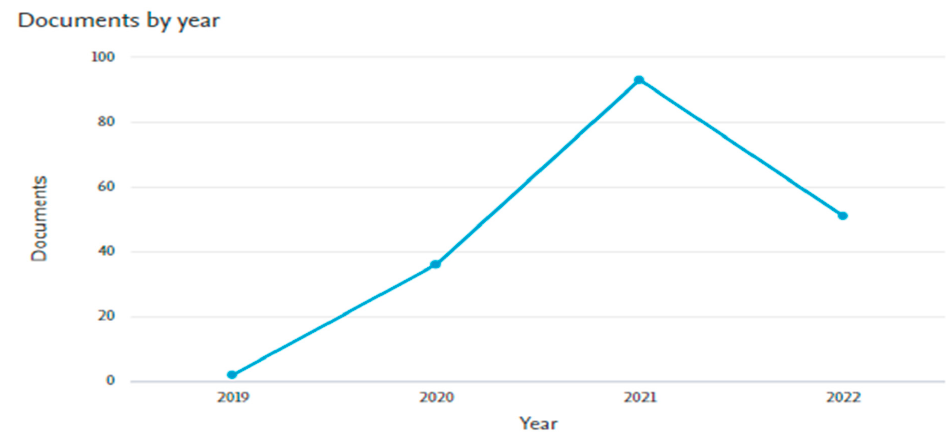
Figure 4. Evolution of the number of publications per year—Scopus.